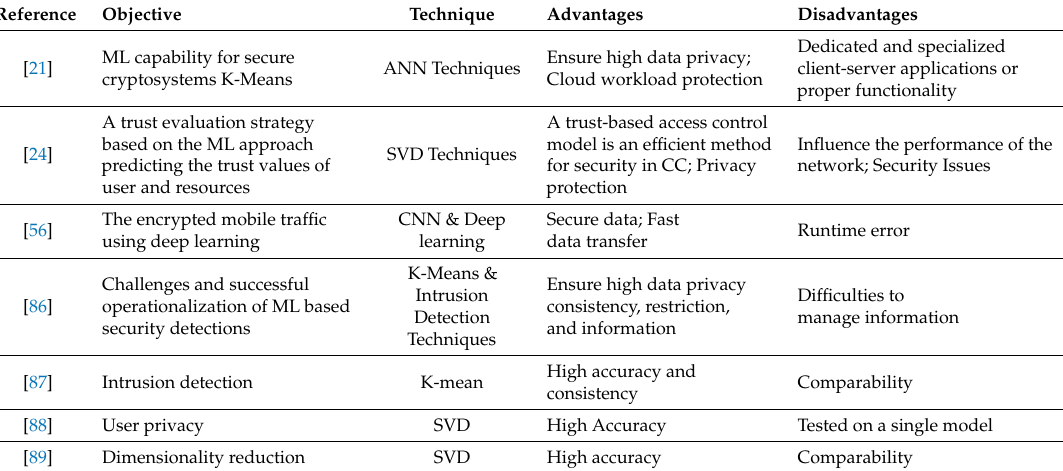
Table 4. Comparison of unsupervised learning techniques for cloud